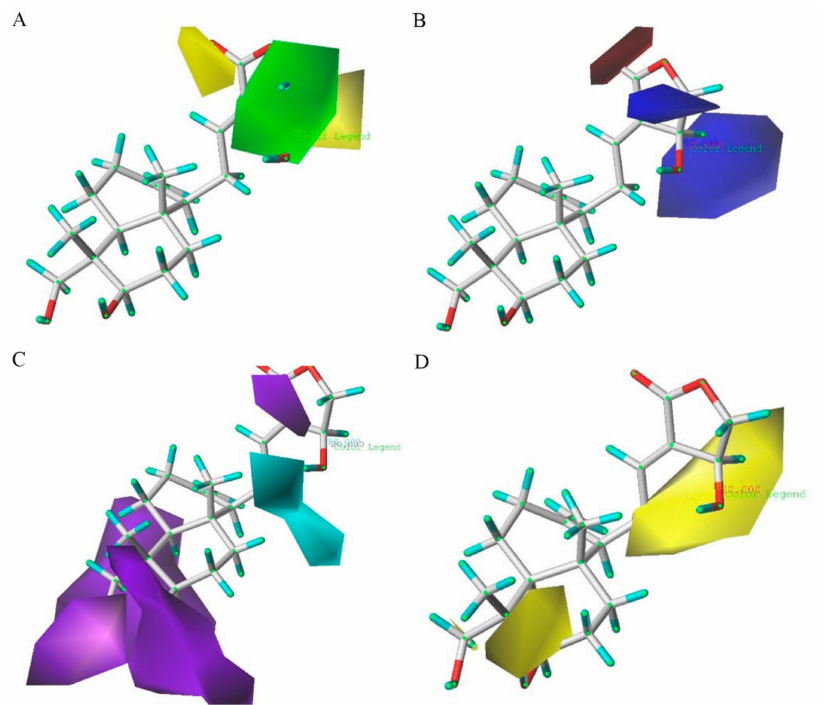
Figure7. CoMSIAStDev*Coeffcontourplotswiththecombinationofcompound AP-6 ingroup1. ( A )Steric field: green and yellow contours refer to sterically favored and unfavored regions. ( B ) Electrostatic field: blue and red contours refer to regions where electron-donating and electron-withdrawing groups are favored, respectively. ( C ) Hydrogen bond donor field: the cyan and purple contours indicate favorable and unfavorable hydrogen bond donor groups. The contour plots of the hydrophobic field are depicted in figure ( D ); Hydrophobic field: yellow represents regions where hydrophobic groups increase activity; red represents regions where hydrophobic groups decrease